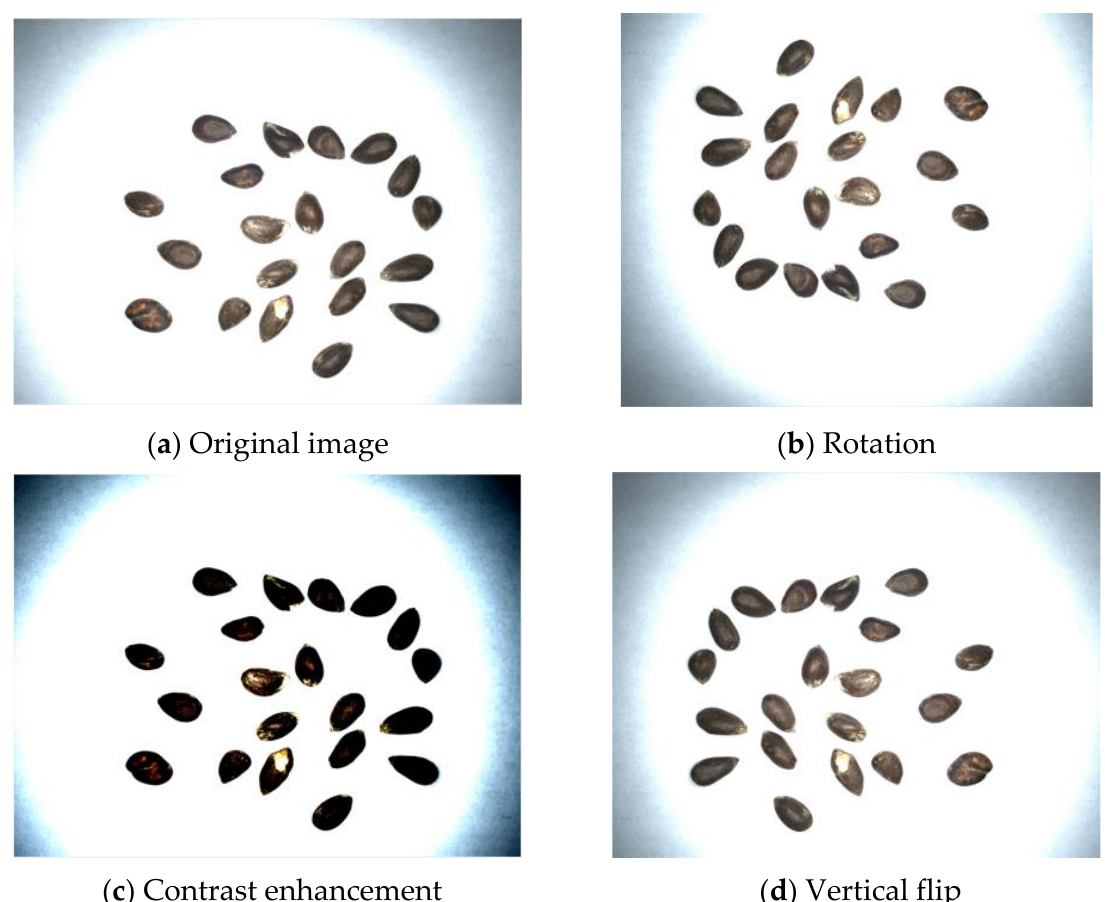
Figure 1. Cottonseed data enhancement.